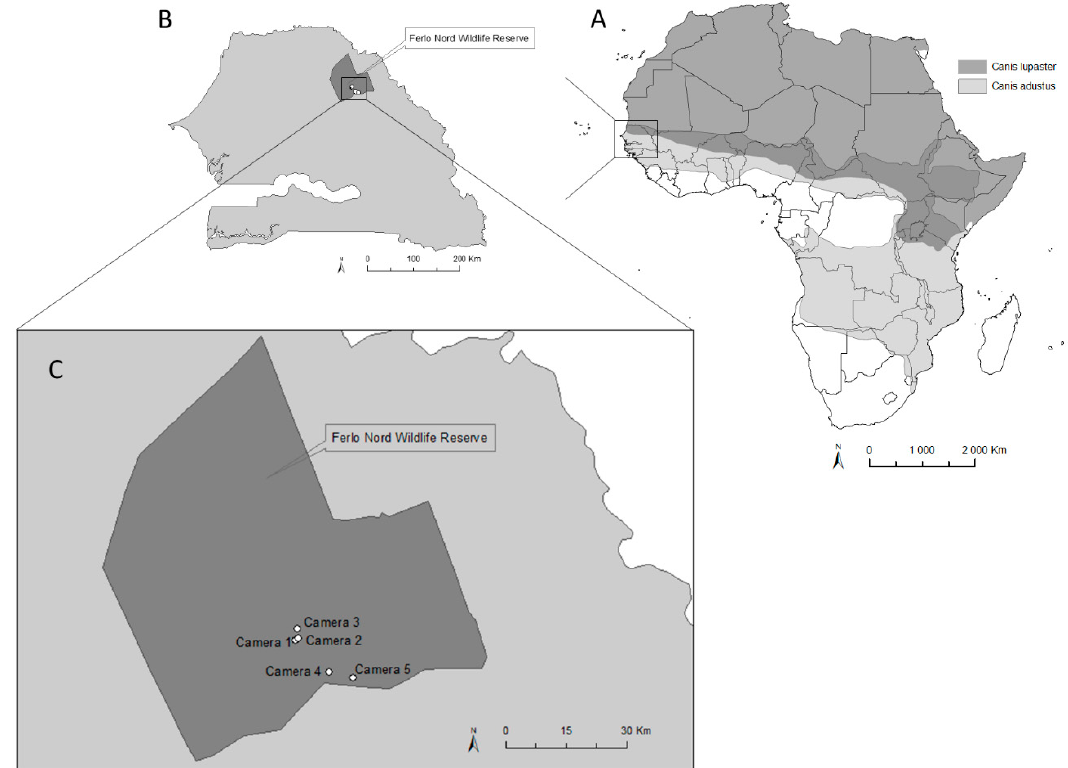
Figure 1. Distribution of the African wolf ( Canis lupaster ) and the side-striped jackal ( Canis adustus ) in Africa, and their range overlap (darkest grey) (source: https://www.iucnredlist.org/) ( A ). Location of the study area in Ferlo Nord Wildlife Reserve (Senegal, West Africa) ( B ) and the positions of the 5 artificial waterholes monitored by camera-trapping ( C ).